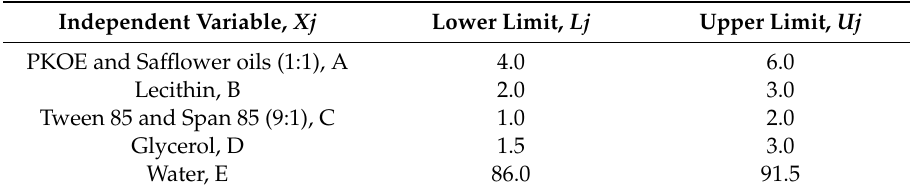
Table 6. Limits of the formulation of independent